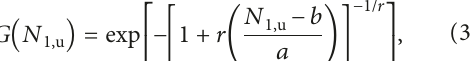
− M and M 1 , u 3 , u